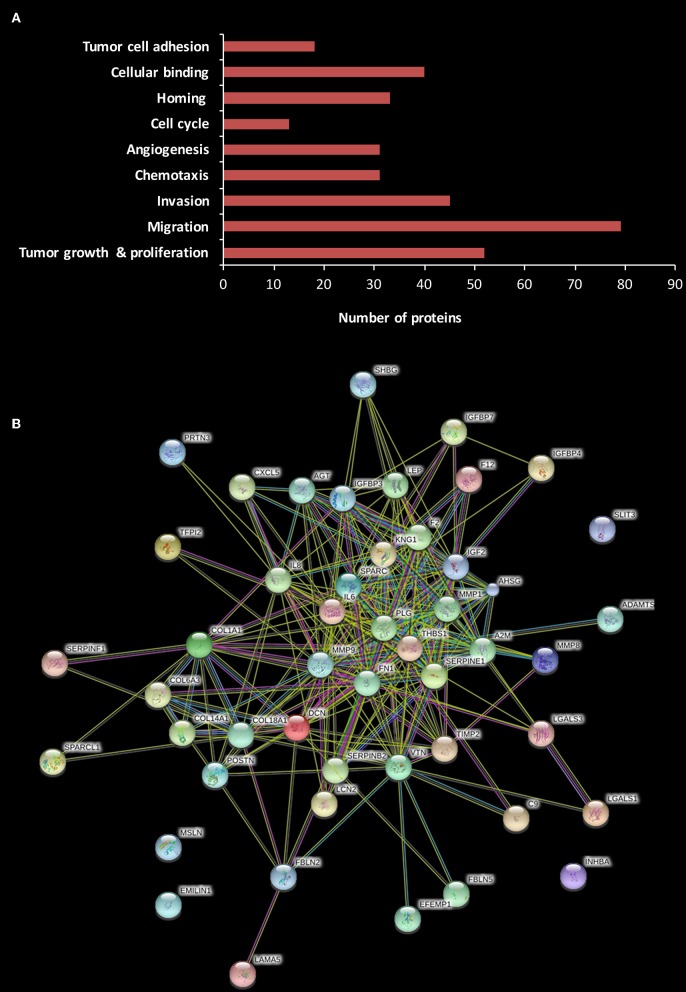
Human omental tissue secretome includes various pro-tumorigenic factors. (A) Functional annotation of differentially expressed proteins in omental tissue CM compared to SC fat CM. The stacked bar chart shows the number of proteins in each category; (B) Protein-protein interactions network of 52 proteins related to tumor growth and proliferation constructed using STRING analysis.